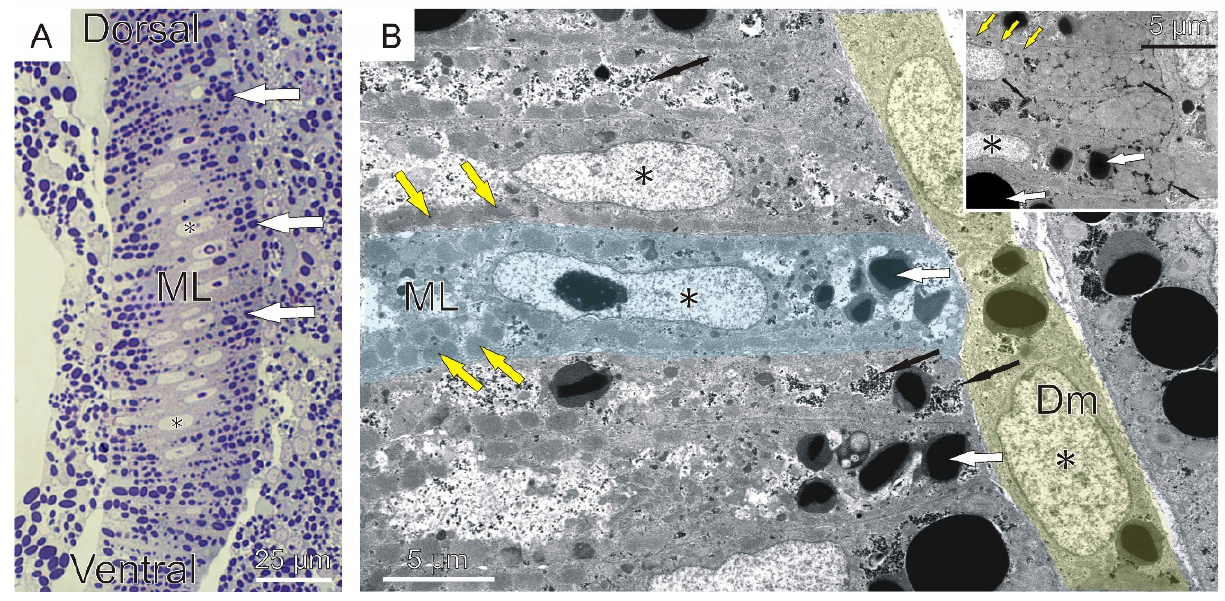
Figure 2. Formation of multinucleated muscle lamellae during river lamprey ( L. fluviatilis ) myogenesis (stage X). ( A ) Cross section through the trunk muscles stained with methylene blue. ( B ) Ultrastructure of the embryo skeletal muscles. Inset—terminal parts of muscle lamellae. Muscle lamellae (ML, colored in blue at ( B )), yolk platelets (white arrows), dermomyotome (Dm, colored in yellow), myofibrils (yellow arrows), glycogen granules (black, thin arrows), nuclei (*).